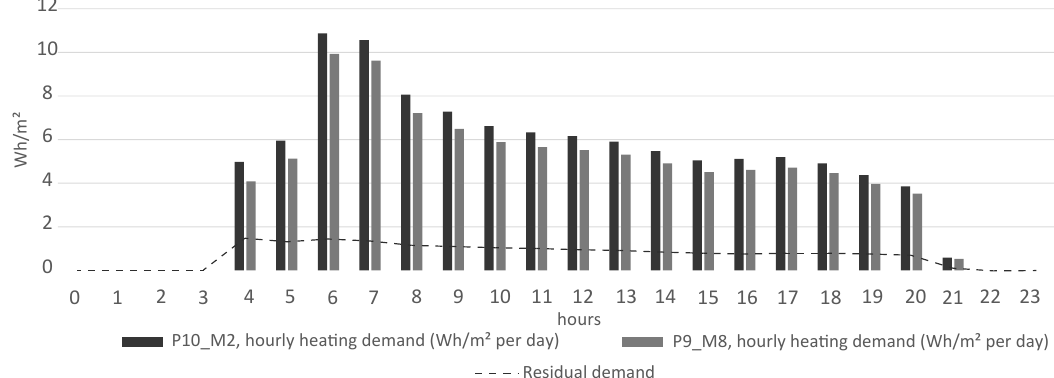
Figure 5. Comparison of heating demand in Wh/m 2 per day in the months of April and May of 2017 of the models evaluated with the old methodology: ZEC _ index (P10_M2) and with logNSE (P9_M8).